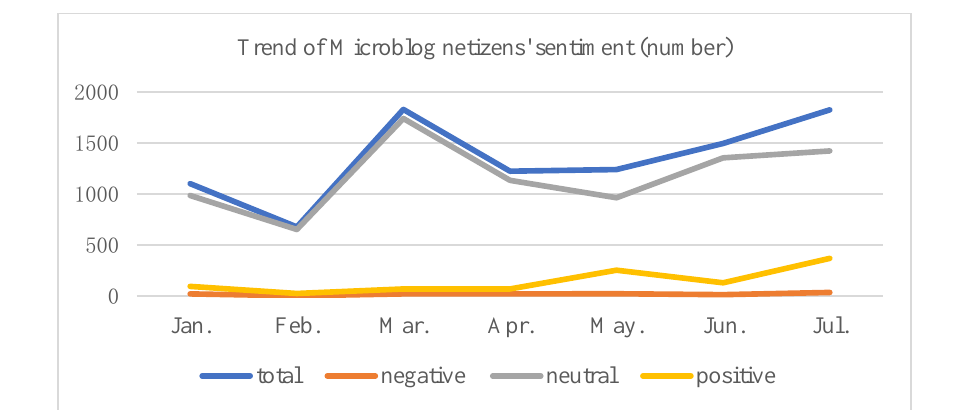
Fig. 5. Trend of Microblog netizens' sentiment (number).